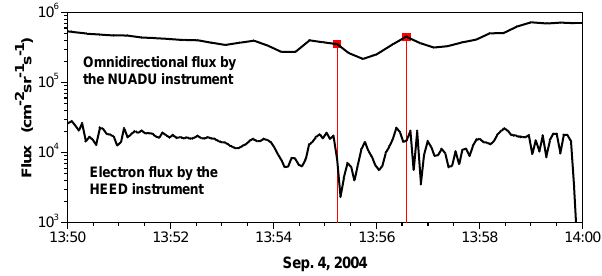
Fig. 10. The omnidirectional electron flux (top line) recorded by The omnidirectional electron flux (top line) recorded by NUADU in NUADU in Energy Channel 3 (49.2–125keV) on 4 September Energy Channel 3 (49.2-125 keV) on 4 September, 2004, and the corresponding high 2004, and the corresponding high energy (0.2–0.4MeV), omnidi- energy (0.2 – 0.4 MeV), omnidirectional, electron flux (bottom line) observed by the rectional, electron flux (bottom line) observed by the HEED instru- HEED instrument. The vertical red lines indicate the period of the observations under ment. The vertical red lines indicate the period of the observations study (Fig. 6). under study (Fig. 6).